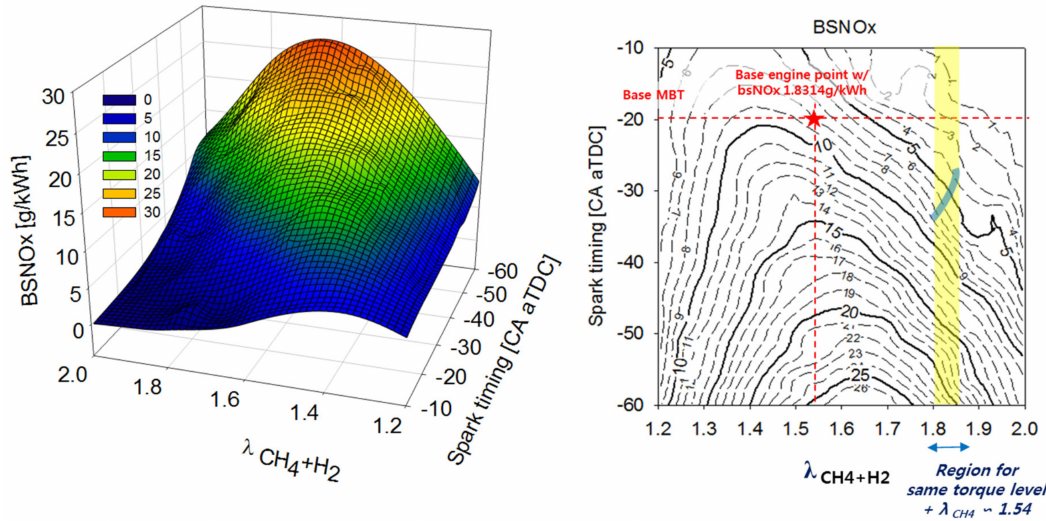
Figure 7. Response surface model: brake specific NOx as functions of spark timing and hydrogen added methane based EAR @1000